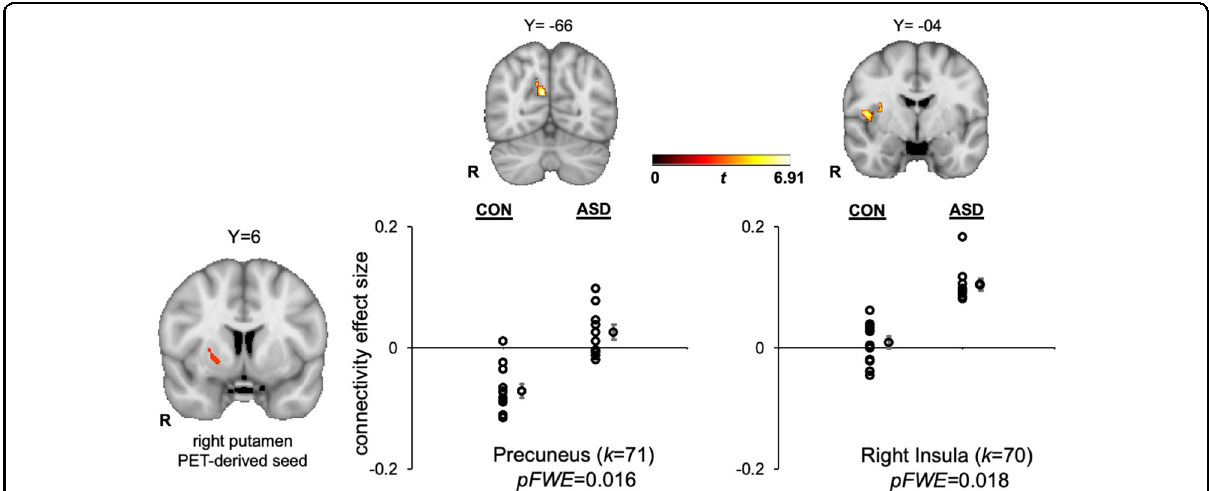
Fig. 3 ASD > control differences in general functional connectivity between the PET-derived right putamen seed and precuneus (MNI coordinates: X = 8, Y = − 66, Z = 24) and right insula (MNI coordinates: X = 48, Y = − 4, Z = 10). Clusters are displayed in MNI152 space at peak coordinates for each target region and family-wise-error cluster corrected at p < 0.05. The dot plots show the effect size for each target region, represented by the Fisher-transformed correlation coef fi cients, separated by group. Individual data points are displayed next to the group average with standard error bars. k = cluster size in